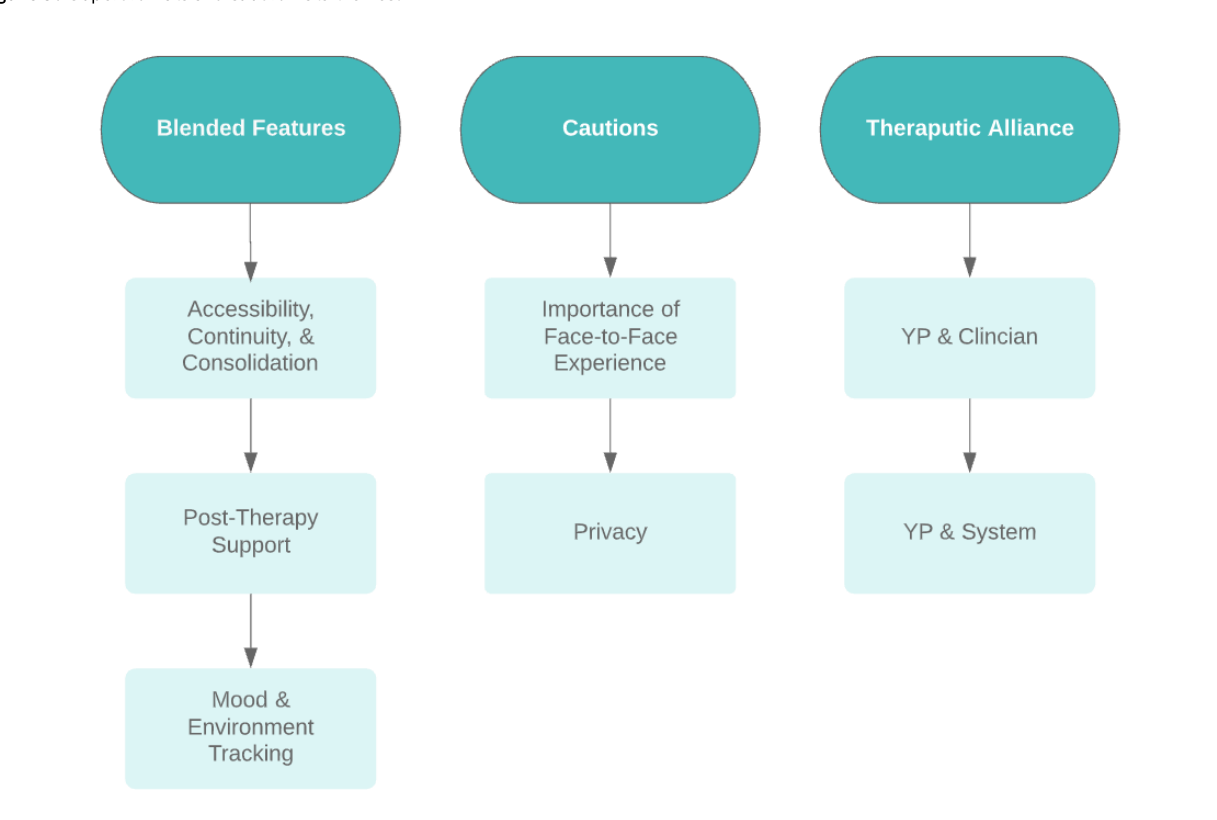
Figure 3. Superordinate and subordinate